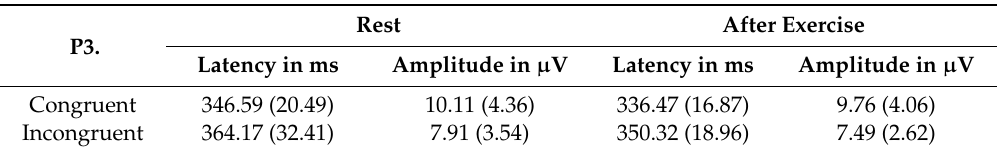
Figure 6. Grand average ERP waveform ( N = 11) averaged across parieto-central electrode sites (P3, Pz, P4, CP1, CP2, Cz) depicting the neural responses (in particular the P3) to congruent (solid) and incongruent (dashed) trials at rest (black) and immediately after an acute bout of moderate-intensity exercise (grey). Topographical distributions at the time of P3 peak are shown for the congruent condition at rest (solid, black frame) and after exercise (solid, grey frame). Table 5. Mean (SD) P3 peak latencies and amplitude for congruent and incongruent conditions at rest and after exercise at electrode site